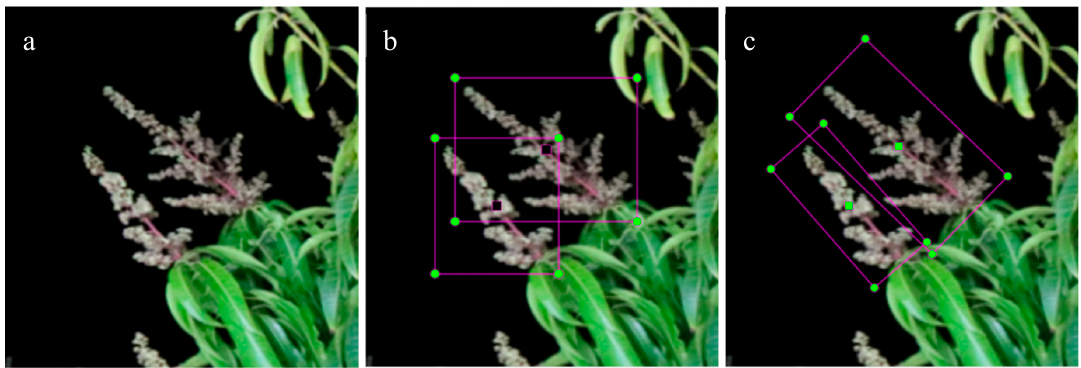
Figure 1. ( a ) Original image, ( b ) upright bounding box and ( c ) rotated bounding box.